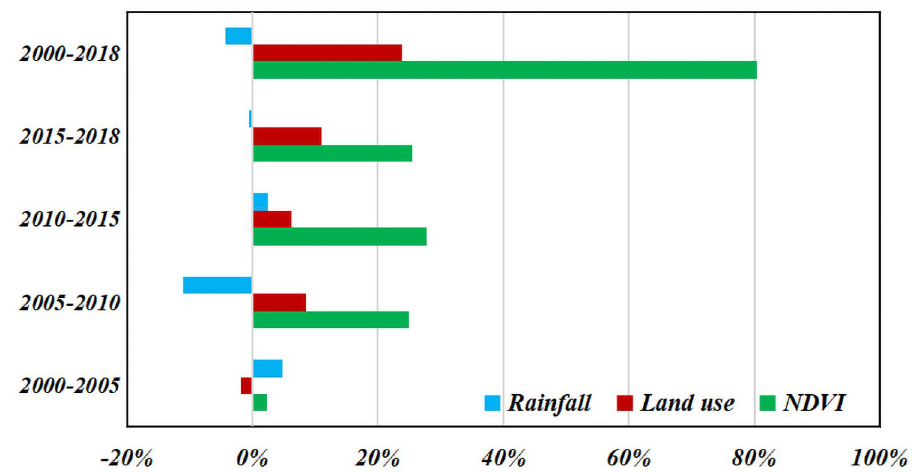
Fig 8. Relative contributions of rainfall, land use, and NDVI to soil erosion changes during four